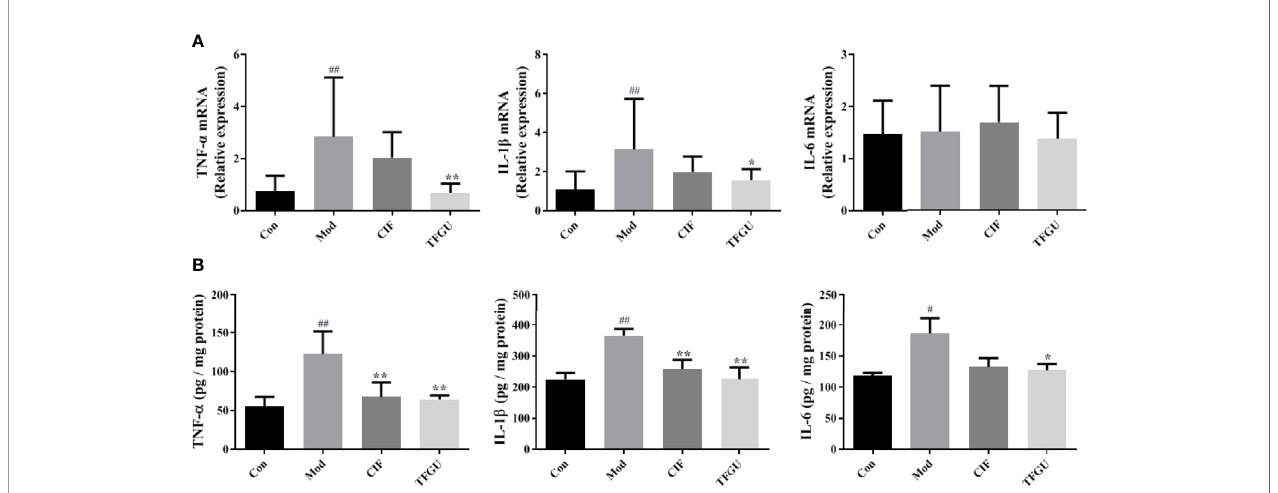
FIGURE 3 | The effects of TFGU on mRNA expressions (A) and protein levels (B) of pro-in fl ammatory cytokines in colonic tissue. Date are shown as mean ± SD (n = 6 mice/group). # P < 0.05, ## P < 0.01 vs. Con group, while * P < 0.05, ** P < 0.01 vs. Mod